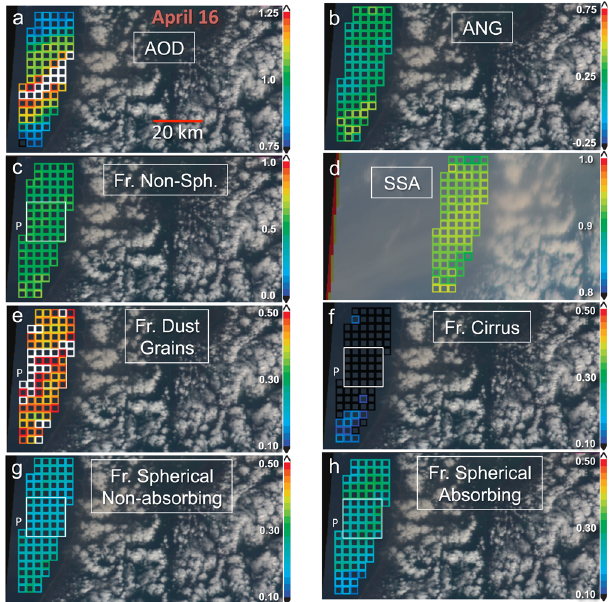
Fig. 6. Same as Fig. 3, but showing results for the 16 April 2010 plume far downwind near Cabauw, the Netherlands. The region shown here is indicated by the arrow in Fig. 1c. North is roughly toward the top. The multi-angle images were co-registered to 2km, the approximate elevation of the ash plume, and the surface wind speed was set to 5ms − 1 . The χ 2 threshold for the patches in max3 this image was set at p min + 0 .